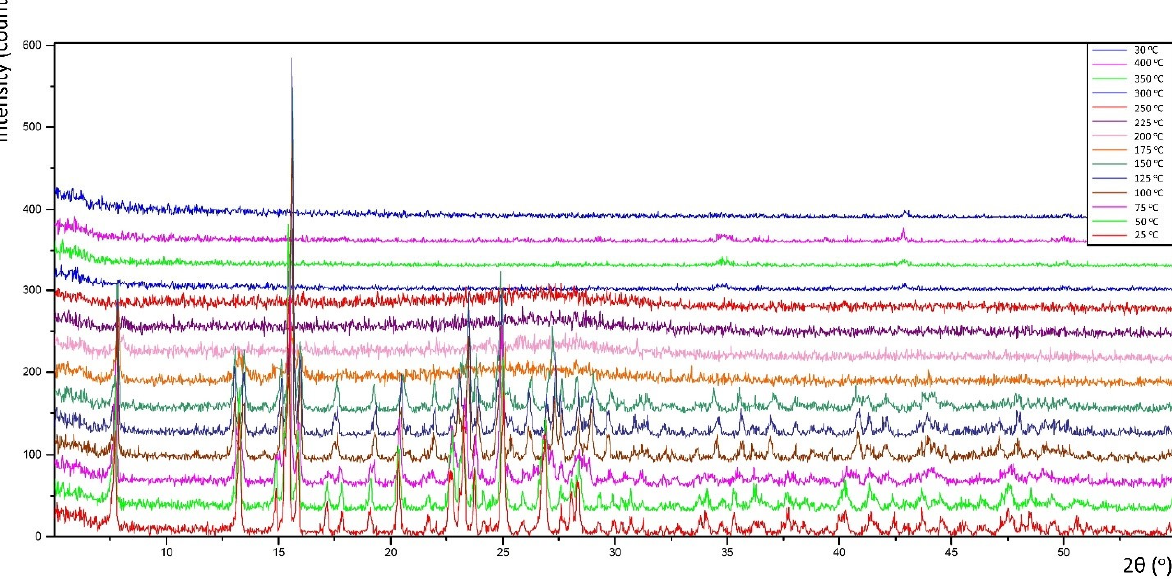
Figure 5. Thermal decomposition for the compound K35dcpa (see text for description).